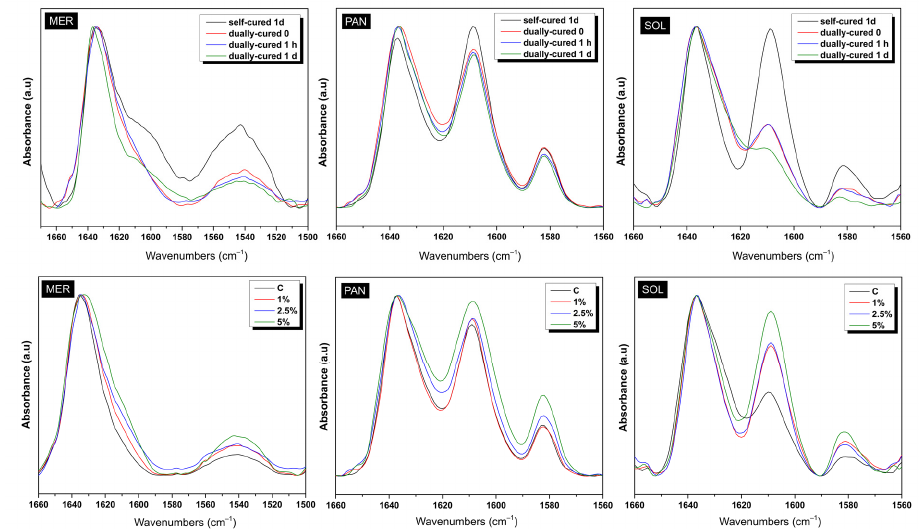
Figure 2. Comparisons of the limited-area spectra for all cements. ( Top ) Effect of curing and ( Bottom ) influence of the nanoparticle (NP) content on the polymerization progress. MER = Meron plus QM, SOL = Solocem, PAN = Panavia SA Universal, C = control without NPs, 1% = 1% wt. NPs, 2% = 2% wt. NPs, 5% = 5% wt. NPs. Table 1. The DC % results derived from the FTIR calculations for all materials when ZrO 2 powder was added in the mixture (mean ± s.d., n = 2). MER = Meron plus QM, PAN = Panavia SA Universal, SOL = Solocem.